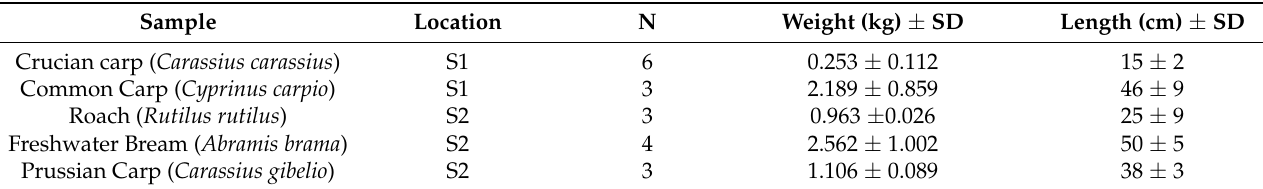
Table 1. Biometrics data (mean ± SD) of freshwater fishes from the Black Sea